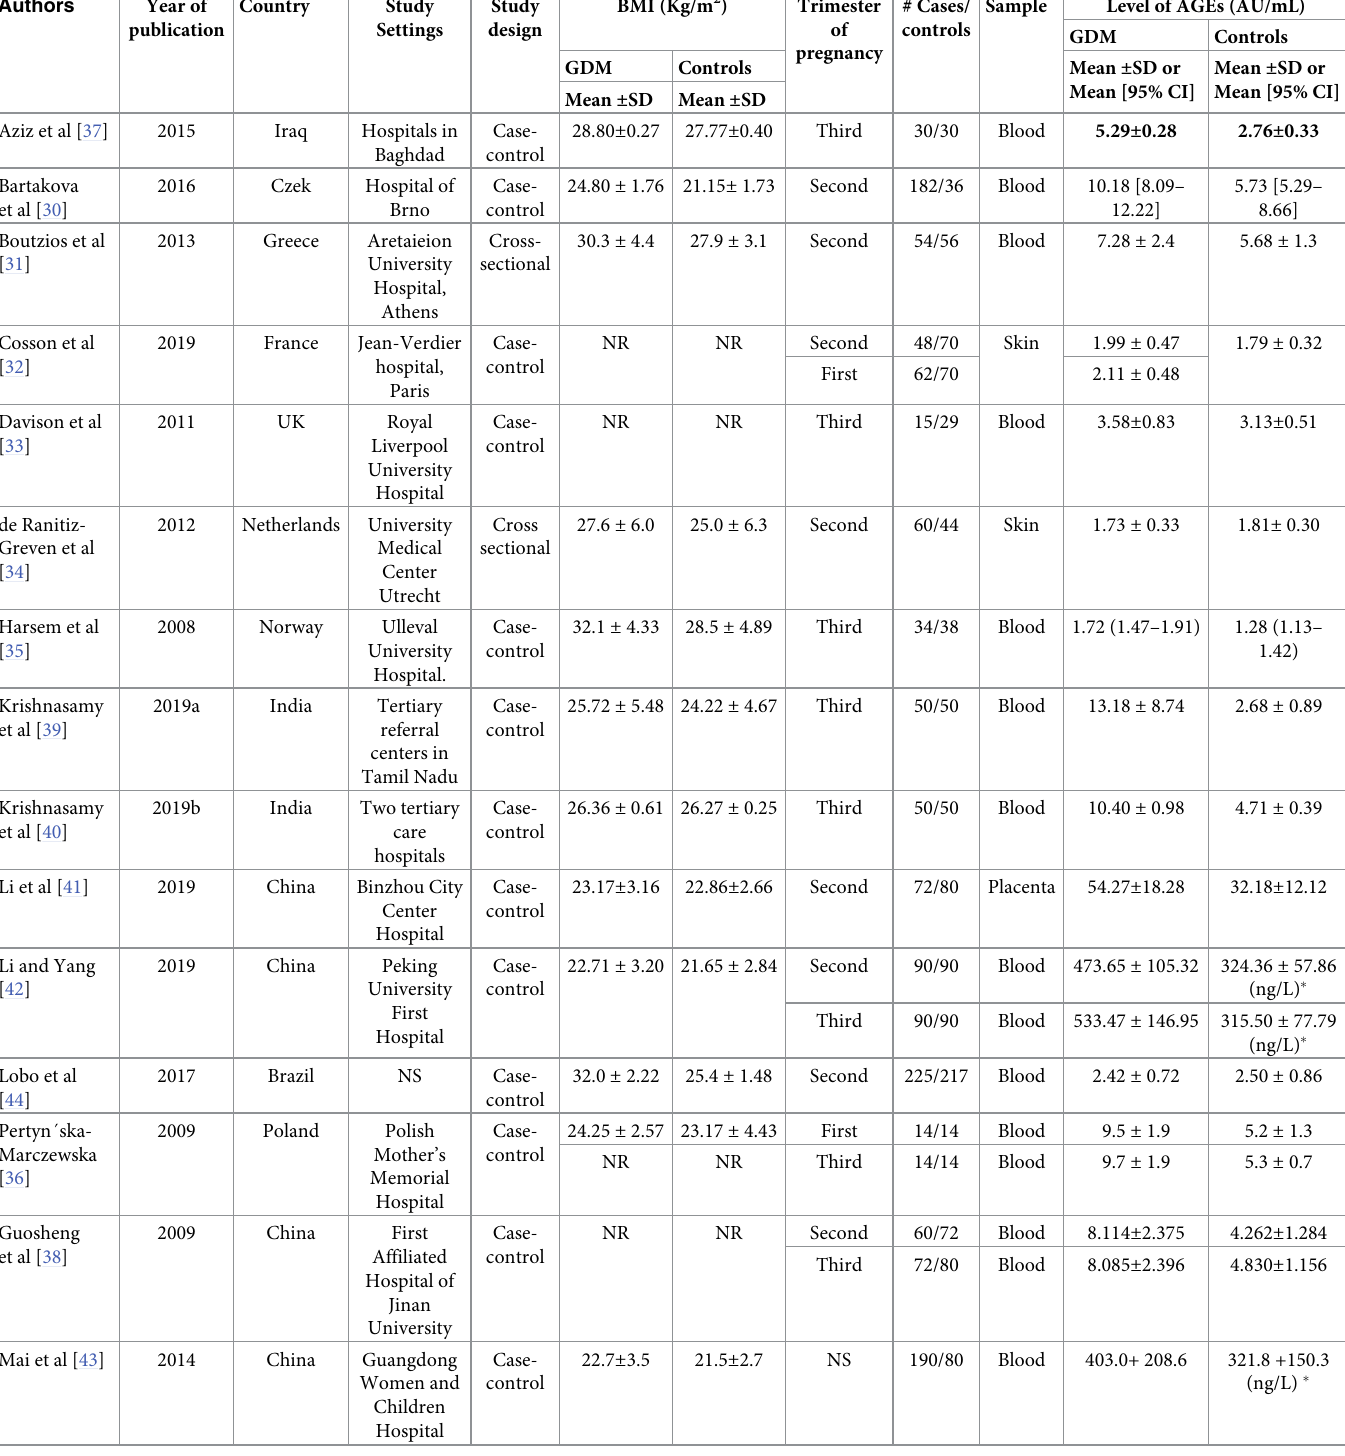
Table 1. Study characteristics of diabetic and non-diabetic pregnant women included in the study.